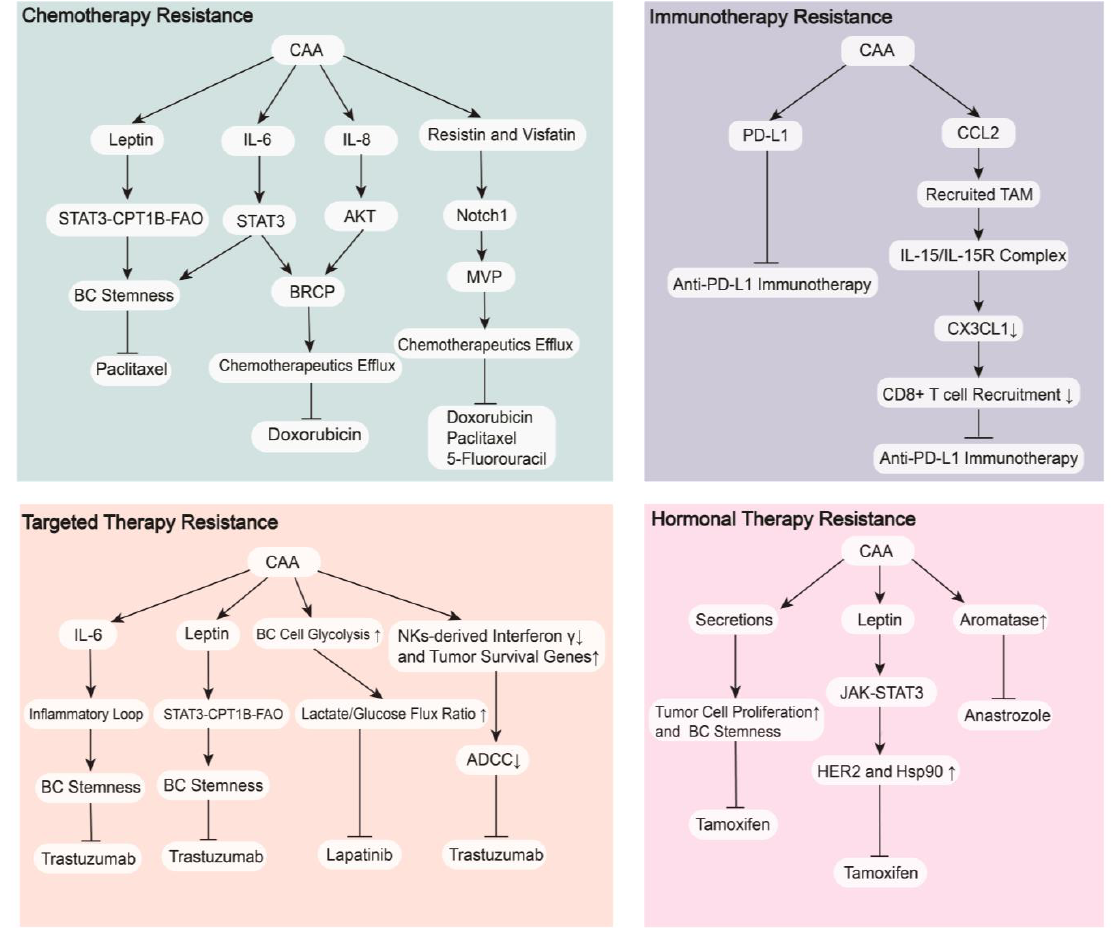
Figure 4. CAAs lead to therapeutic resistance in BC. CAAs secrete IL-6, IL-8, leptin, resistin and visfatin to cause chemotherapy resistance in BC. CAAs secrete PD-L1 and CCL2 to cause immunotherapy resistance in BC. CAAs secreting IL-6 and leptin, increasing BC cell glycolysis, decreasing NK-derived interferon, and increasing tumor survival genes cause targeted therapy resistance in BC. CAAs secreting leptin and other secretions and increasing expression of aromatase cause hormonal therapy resistance in BC. Abbreviations: BC, breast cancer; CAAs, cancer-associated adipocytes; IL-6, interleukin-6; IL-8, interleukin-8; HER2, human epidermal growth factor receptor 2; ADCC, antibody- dependent cellular cytotoxicity; BRCP, breast cancer resistance protein; Hsp90, heat-shock protein 90; STAT, signal transducer and activator of transcription 3; CPT1, carnitine palmitoyl transferase 1; FAO, fatty acid oxidation; AKT, protein kinase B; MVP, major vault protein; JAK, Janus tyrosine kinase; NKs, natural killer cells; PD-L1, programmed death-ligand 1; IL-15, interleukin-15; IL-15R, interleukin-15 receptor; CCL2, C-C motif chemokine ligand 2; CX3CL1, C-X3-C motif chemokine ligand 1; CD8+, cluster of differentiation 8